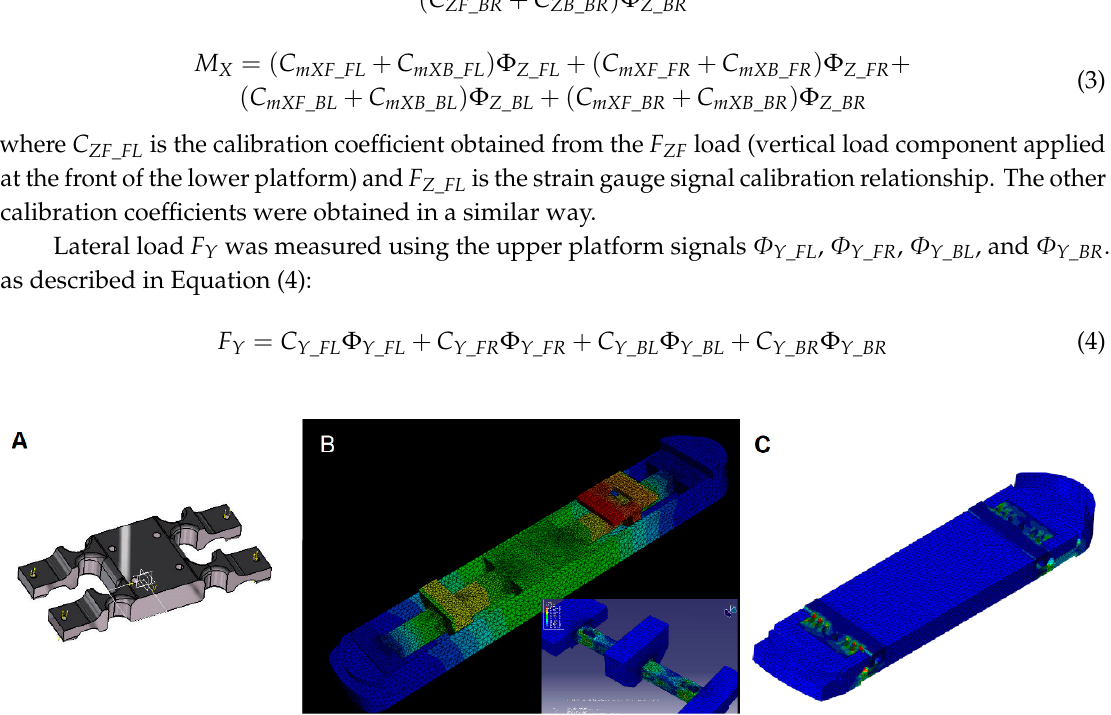
Figure 1. ( A ) First iteration of the design. ( B ) Second iteration of the design with two sensors fixed to a rigid bed. ( C ) Final iteration with an integrated bed and ski binding interface. Sensors were placed on the front and back of the plate. Colors represent the von Mises values (blue: no deformation; red: maximal deformation).